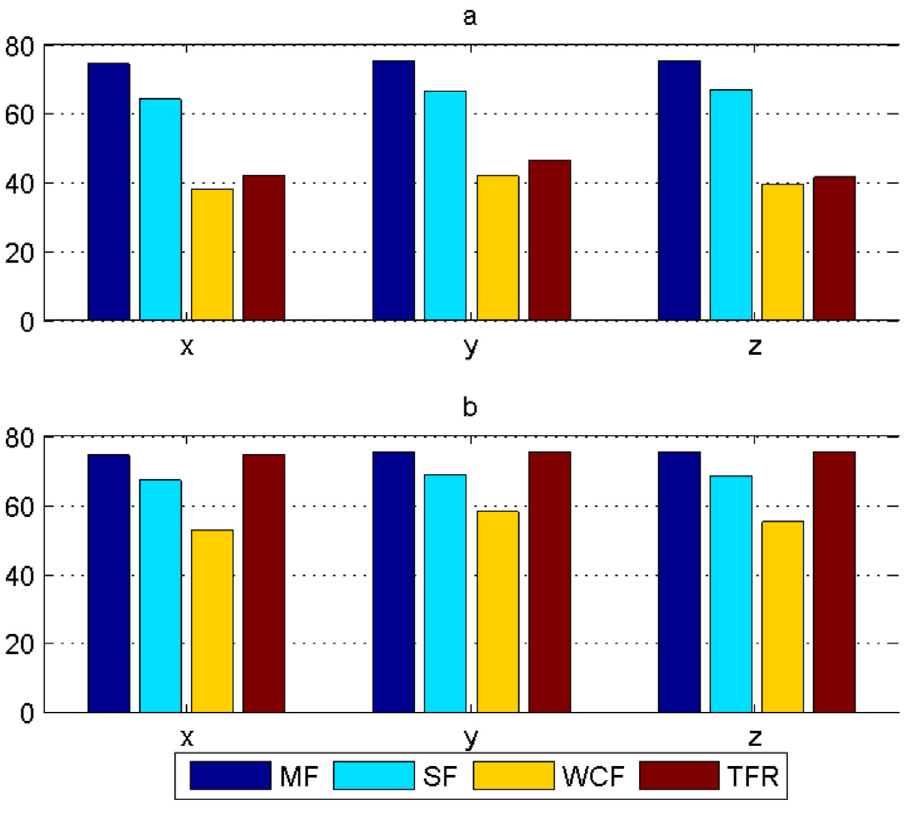
Fig 7. Comparisons of average error among MF, SF, WCF and TFR of 30 targets. (a) Case1, and (b) Case2.